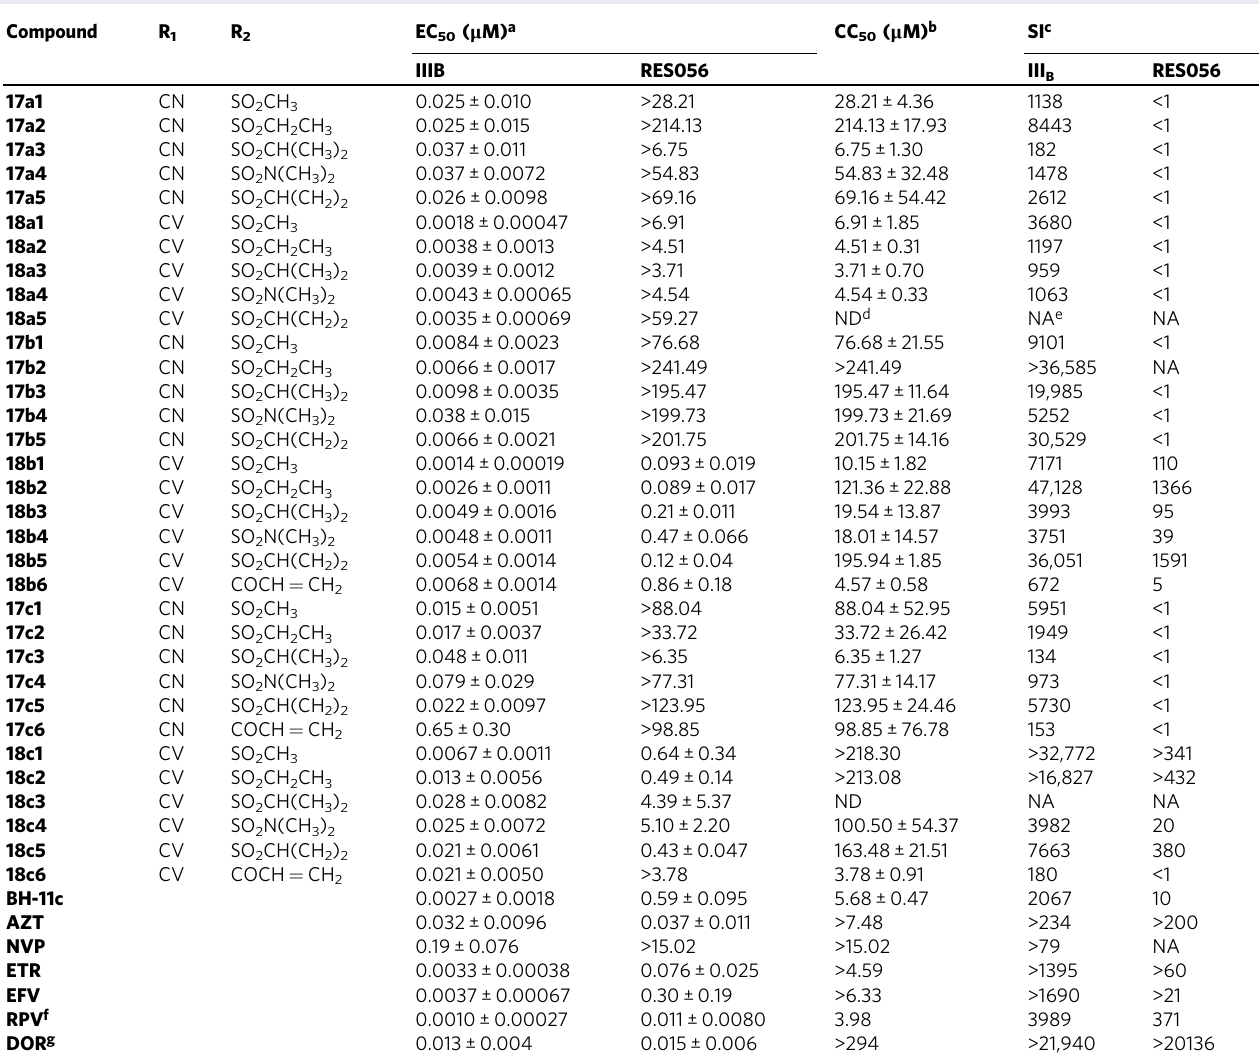
Table 1 Antiretroviral activities against HIV-1 IIIB and RES056 strains, cytotoxicity and selectivity index of the target